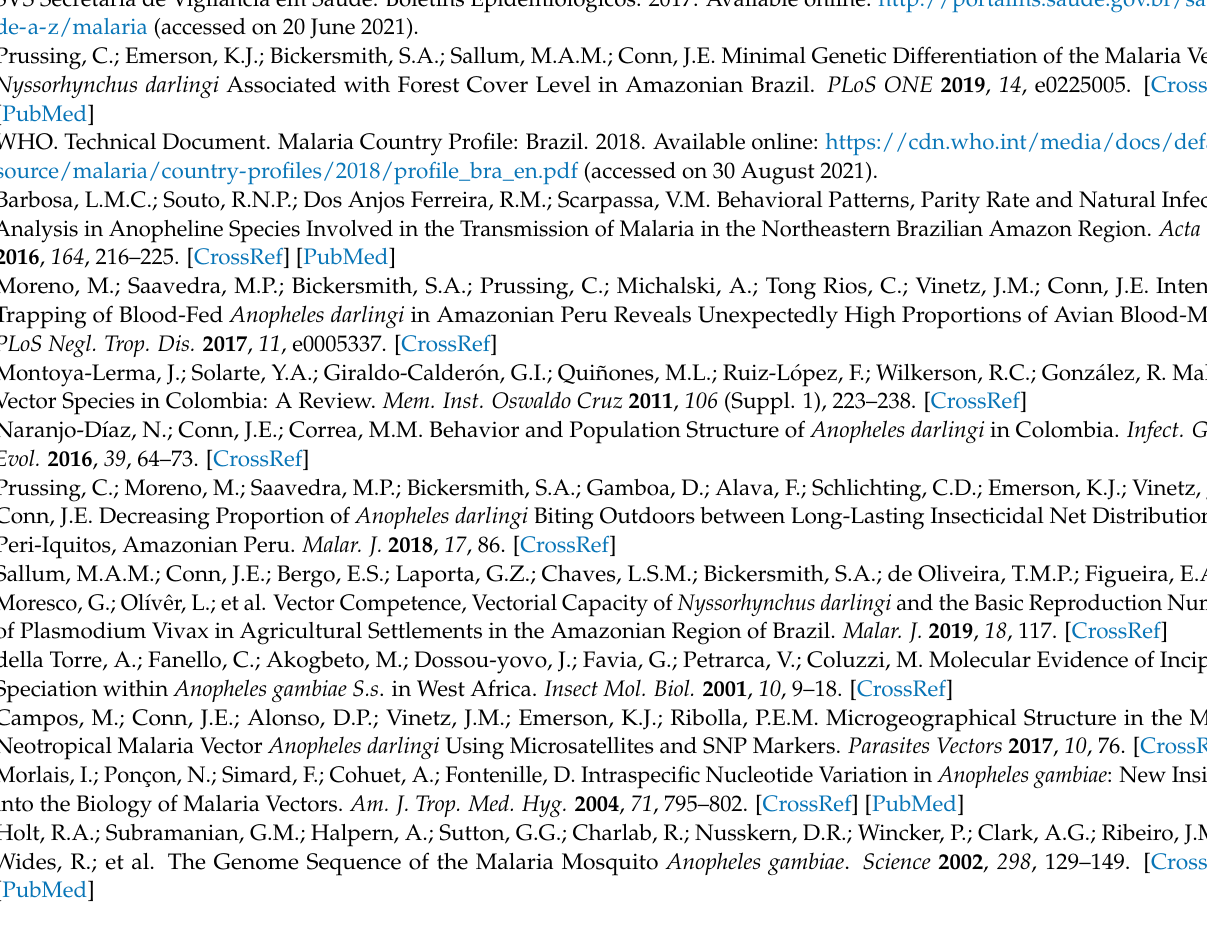
Table S2: Pairwise Fst values for population and case/controls comparisons. Table S3: Top 5 blastp results for chitinase and cyp450 gene products. Figure S1: Fisher test results for P. vivax vs. non-infected and P. falciparum vs. non-infected